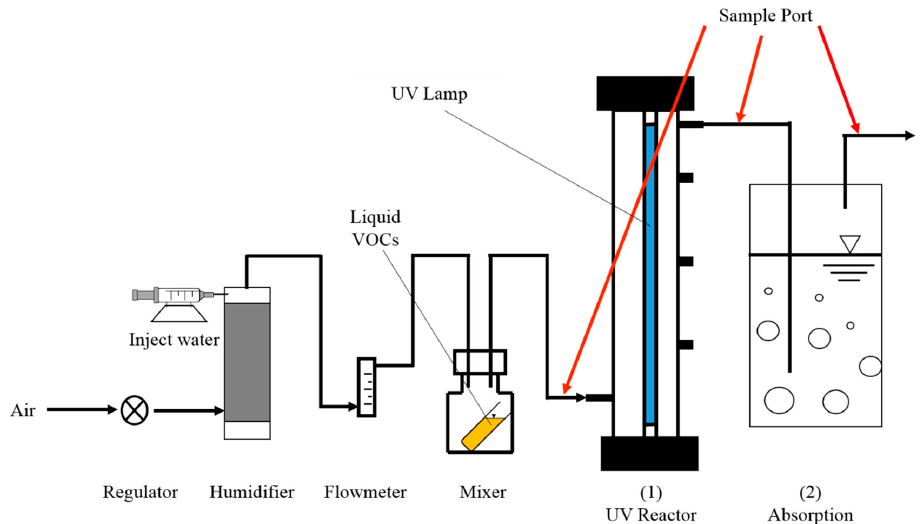
Figure 1. Schematic of the experimental system.